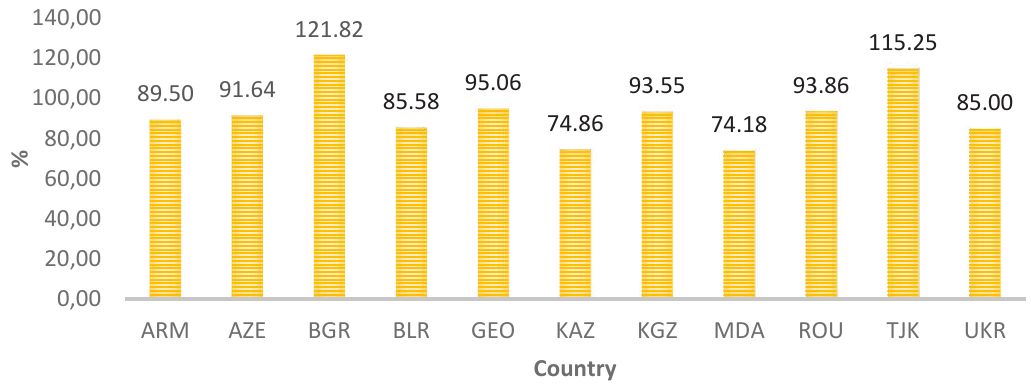
Figure 1. Gini index growth rates in emerging economies (2015 compared with